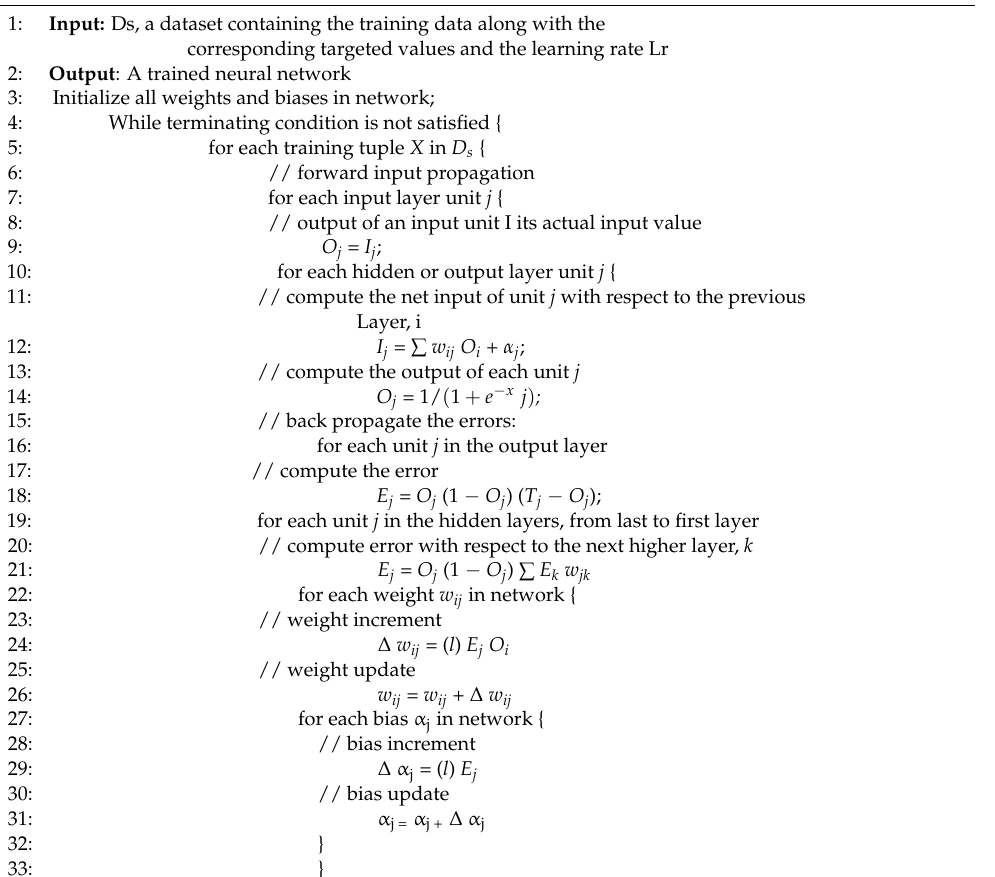
Algorithm 1: Feed-forward back-propagation network (FFBPN) learning for classification